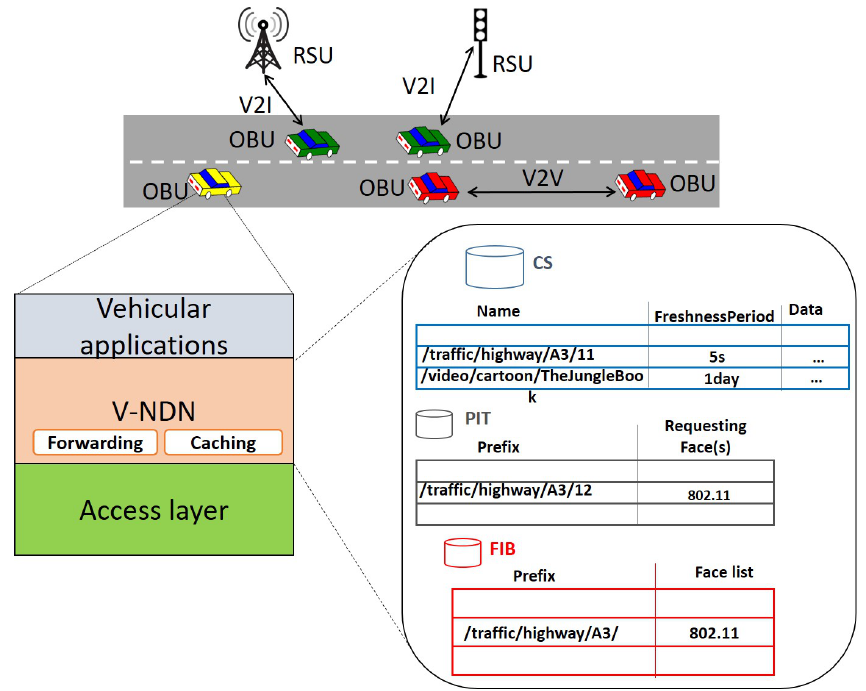
Figure 2. Vehicular communications and V-NDN reference